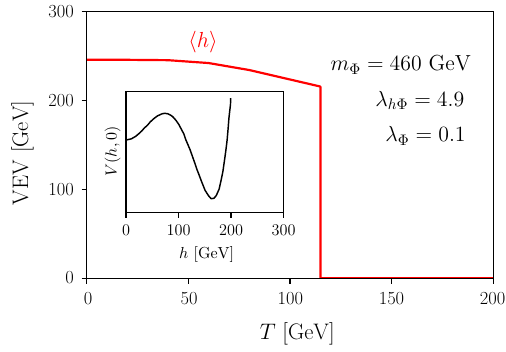
Fig. 4 SameasFig.3butfortheparameterspacepoint m (cid:2) = 460GeV, λ = 4 . 9, λ (cid:2) = 0 . 1. The EWPT proceeds in one step at T H (cid:2) GeV in this case. (cid:11) φ 0 (cid:12) vanishes for all values of T